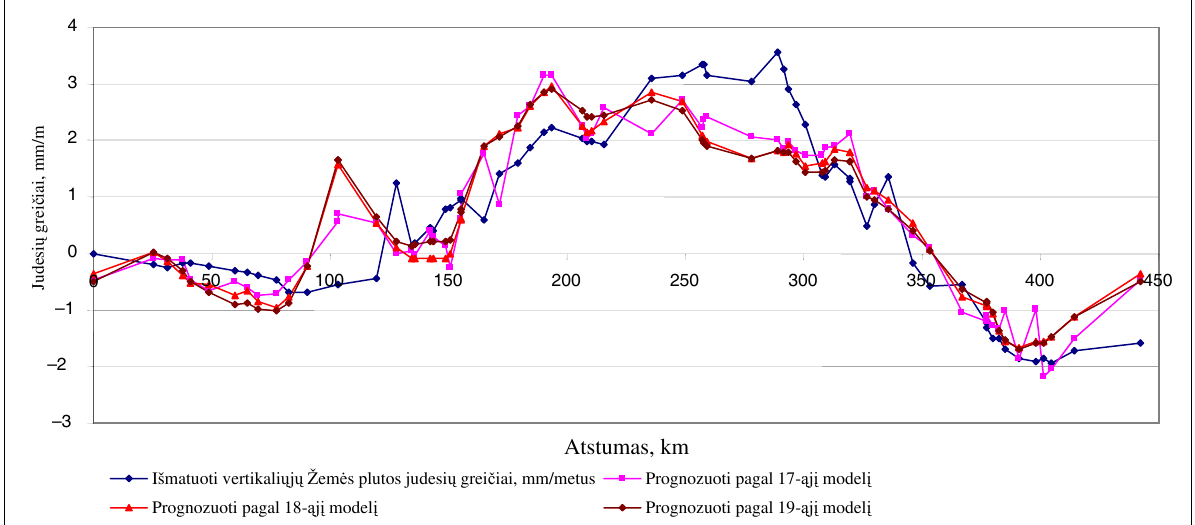
Fig 4. The graphs of measured and forecasted vertical earth crust movements at a polygon of Vilnius – Jonava – Zarasai